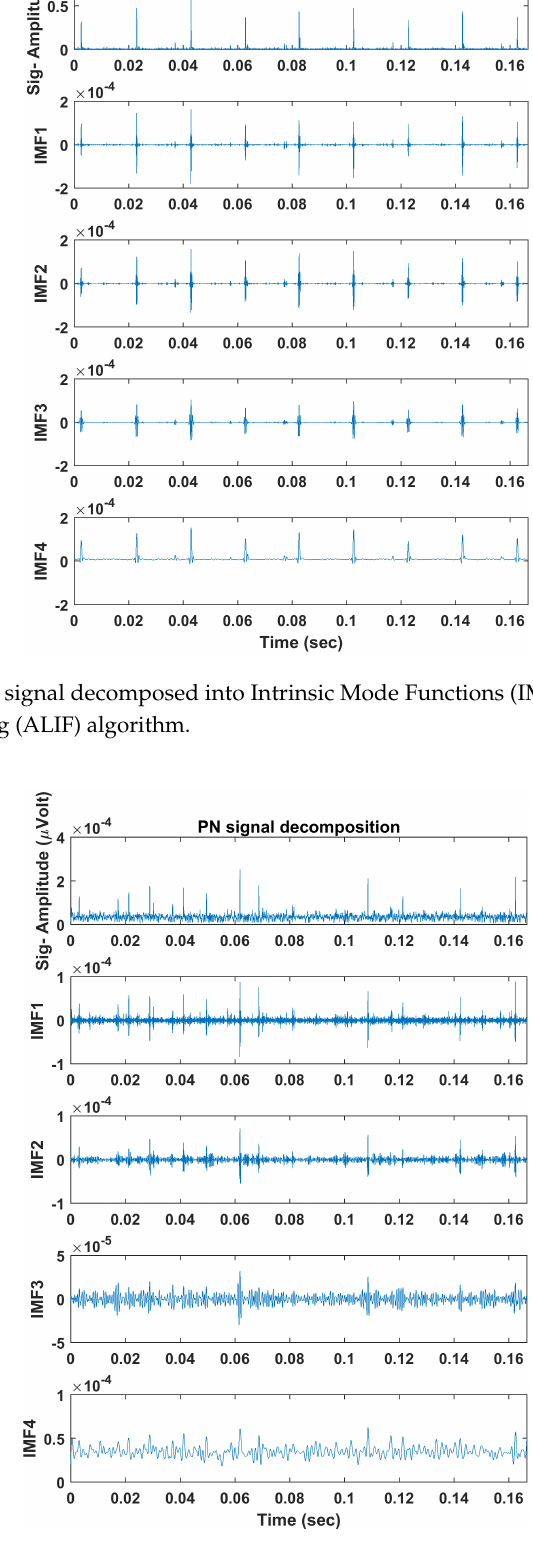
Figure 6. Example PN signal decomposed into IMFs using the ALIF